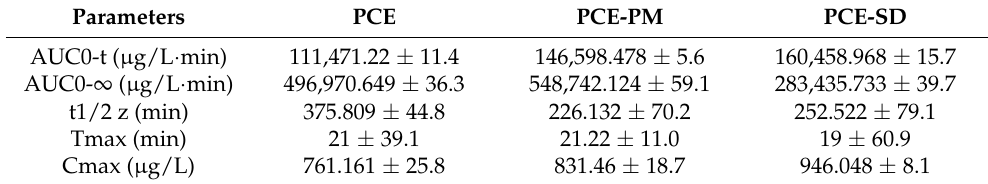
Figure 18. Plasma concentration-time curves in rats after oral administration of PCE, PCE-PM and PCE-SD. Table 9. Pharmacokinetic parameters of PCE, PCE-PM and PCE-SD in rats after oral administration.